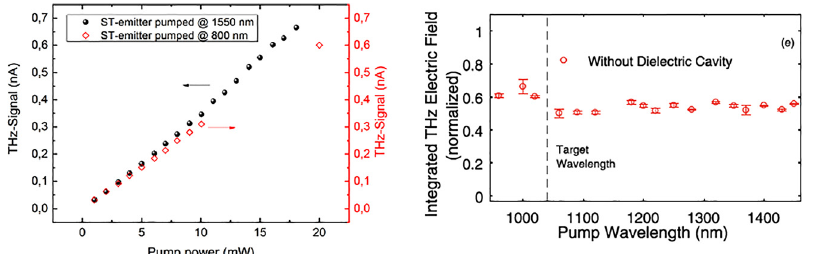
Figure 6: Excitation wavelength dependence of the THz emission. (Leftpanel)MaximumTHz-E-fieldasafunctionofpumppowerofthelaserrecordedat1550nm(blacksquares)and800nmpumpwavelength, λ fi ed from the study by Papaioannou et al. [38], Copyright 2018, IEEE. (Right panel) THz-E- fi eld, emitted from a excitation . Figure modi